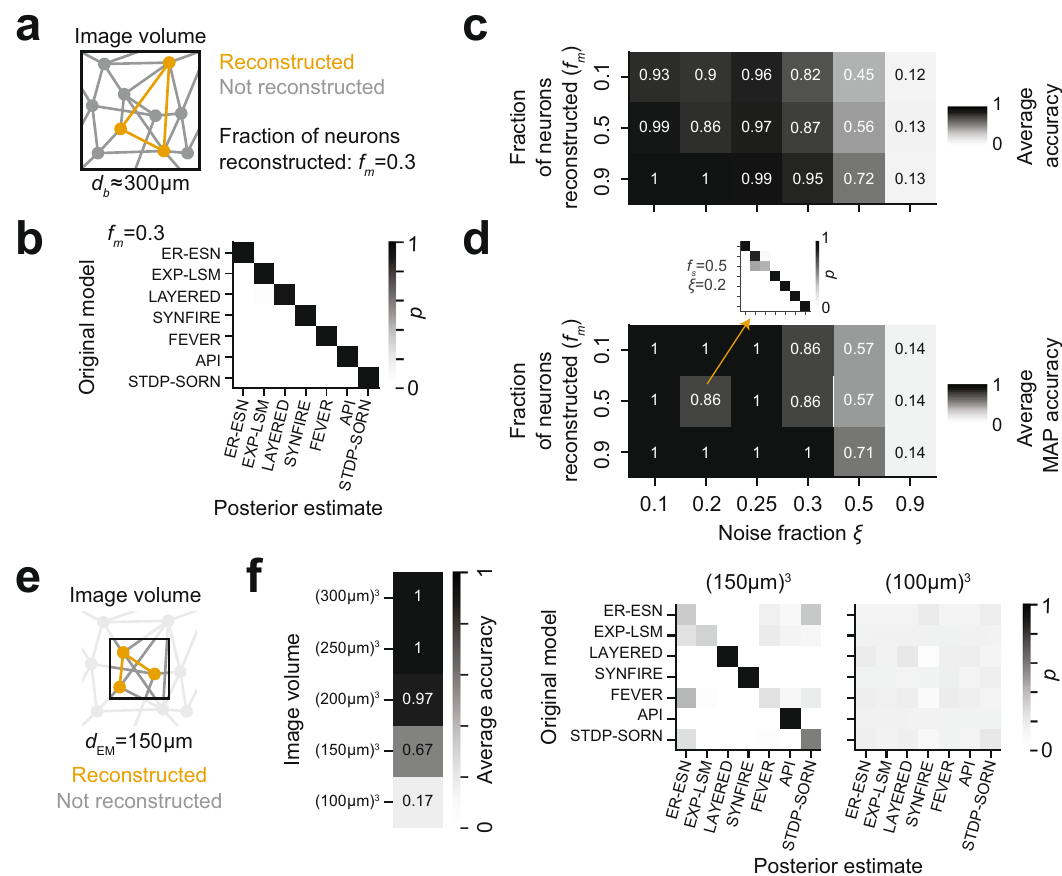
Fig. 5 Model selection for partially measured and noisy connectomes. a Fractional (incomplete) connectome measurement when reconstructing only a fraction f m of the neurons in a given circuit, thus obtaining a fraction f m 2 of the complete connectome. b Effect of incomplete connectome measurement on model selection performance for f m = 0.3 (no noise; n = 1 repetition). Note that model selection is still faithfully possible. c , d Combined effects of noisy and incomplete connectome measurements on model selection accuracy reported as average posterior probability ( c ; n = 1 repetition per entry) and maximum-a-posteriori accuracy ( d ; n = 1 repetition per entry). Note that model selection is highly accurate down to 10% fractional connectome measurement at up to 25% noise, providing an experimental design for model distinction that is realistic under current connectome measurement (Supplementary Fig. 5b). e Effect of fractional dense circuit reconstruction: Locally dense connectomic reconstruction of the neurons and of their connections in a circuit subvolume. f Effect of partial imaging and dense reconstruction of the circuit subvolume on average model selection accuracy (left: n = 1 repetition per entry). Note that model selection based on dense reconstruction of a (150 μ m) 3 volume (12.5% of circuit volume) is substantially less accurate than model selection based on complete reconstructions of 10% in the complete circuit volume (see c ). Right: Posterior distributions over models for image volumes of (150 μ m) 3 and (100 μ m) 3 , respectively ( n = 1 repetition, models (ER-ESN, EXP-LSM, FEVER) showed a high af fi nity for mutual confusion when the original model was excluded during